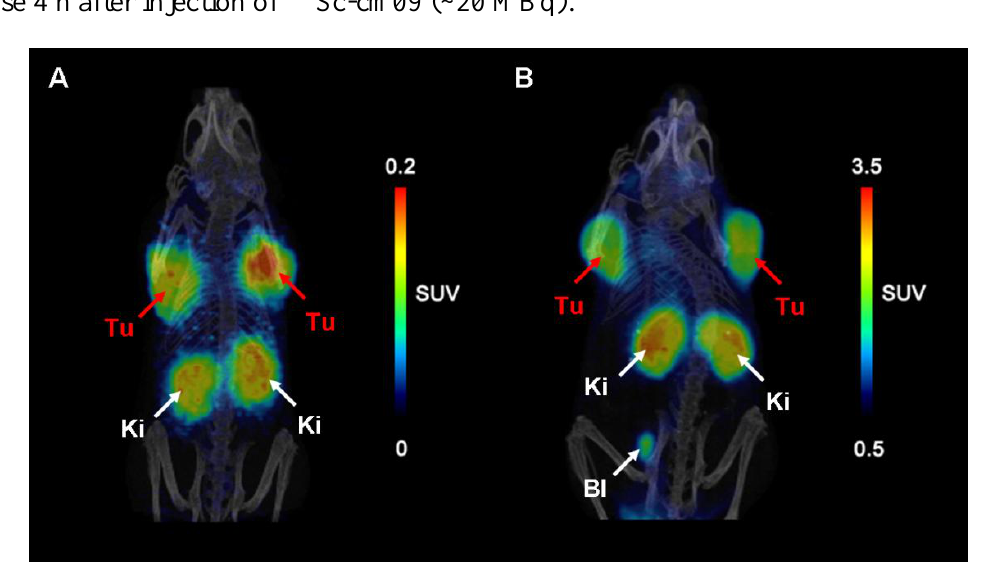
Figure 13. ( A ) Post mortem PET/CT image of a KB tumor bearing mouse 24 h after injection of 152 Tb-cm09 (~10 MBq). ( B ) In vivo PET/CT image of a KB tumor bearing mouse 4 h after injection of 144 Sc-cm09 (~20